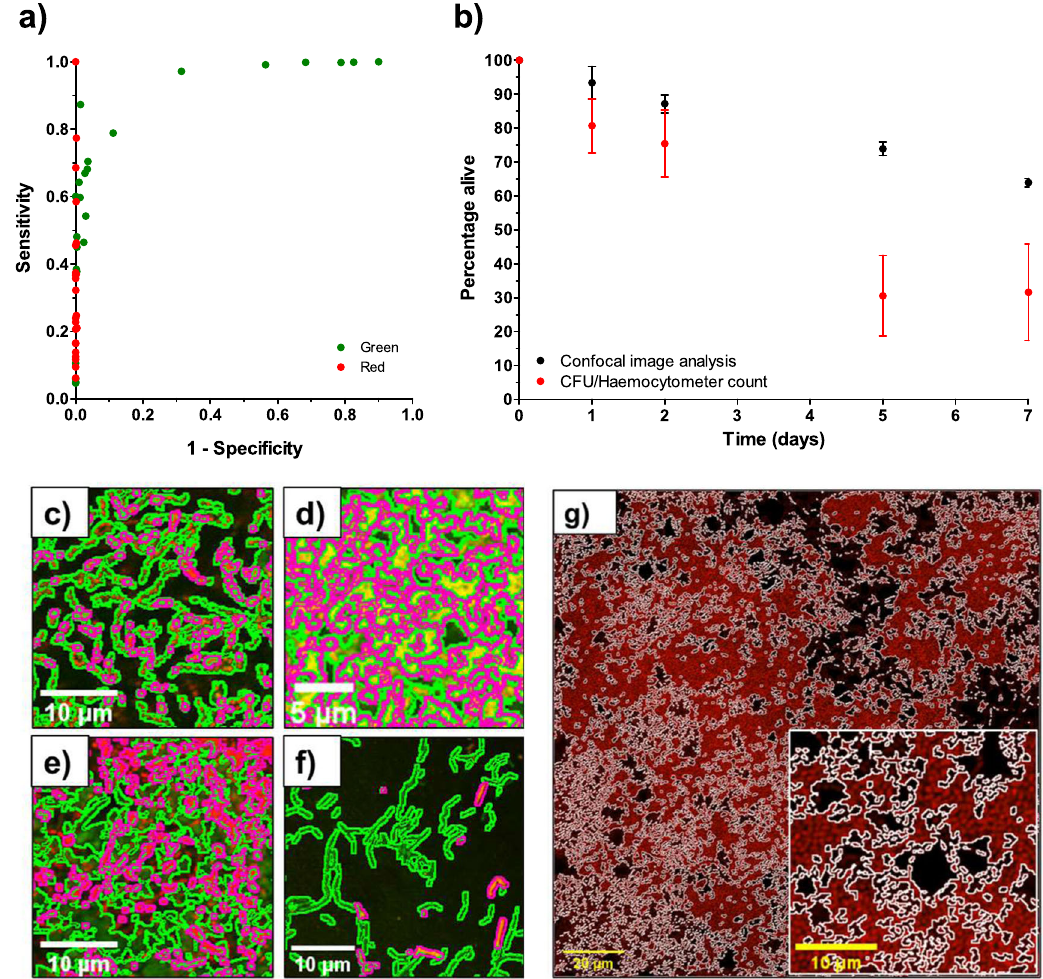
Fig. 2 Results of validation of automatic image analysis protocol. a ROC curve demonstrating sensitivity and speci fi city of the image analysis protocol. Green points represent sensitivity and speci fi city of the green channel (total cells) and red points represent sensitivity and speci fi city of the red channel (dead cells). b Comparison of image analysis and biological methods. Figure shows mean ± standard deviation (for image analysis, fi ve confocal images were analysed of each of fi ve biological replicates, N = 5 and for biological methods, three biological replicates were analysed, N = 3). To obtain the percentage viability using biological methods, live cells were counted using a serial dilution and CFU-plating. Total cell count was obtained using a haemocytometer. c – f Sample images of a variety of single-species bio fi lms demonstrating result of automated image analysis. The green outline indicates the total bacteria area and the magenta outline indicates the dead bacteria area. c S. sanguinis (10 µm scale bar), d P. aeruginosa (5 µm scale bar), e multi-species bio fi lm consisting of F. nucleatum , A. naeslundii , S. gordonii and P. gingivalis (10 µm scale bar), f L. casei (10 µm scale bar). g Representative micrograph of an S. sanguinis bio fi lm treated with 5% CPC to demonstrate the ability of the macro to handle extreme conditions (Full image 20 µm scale bar, small image 10 µm scale bar). The magenta line shows the result of the segmentation of the red channel. The resulting output from the macro is 0%